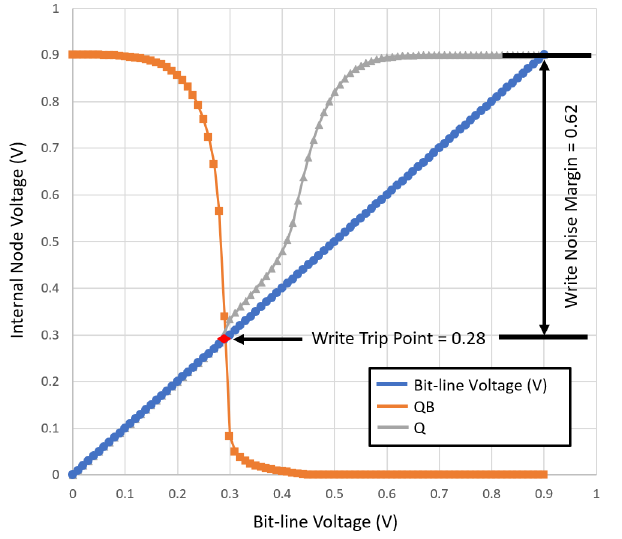
Figure 14. Write Noise Margin (WNM) of the proposed 8T SRAM bit cell.